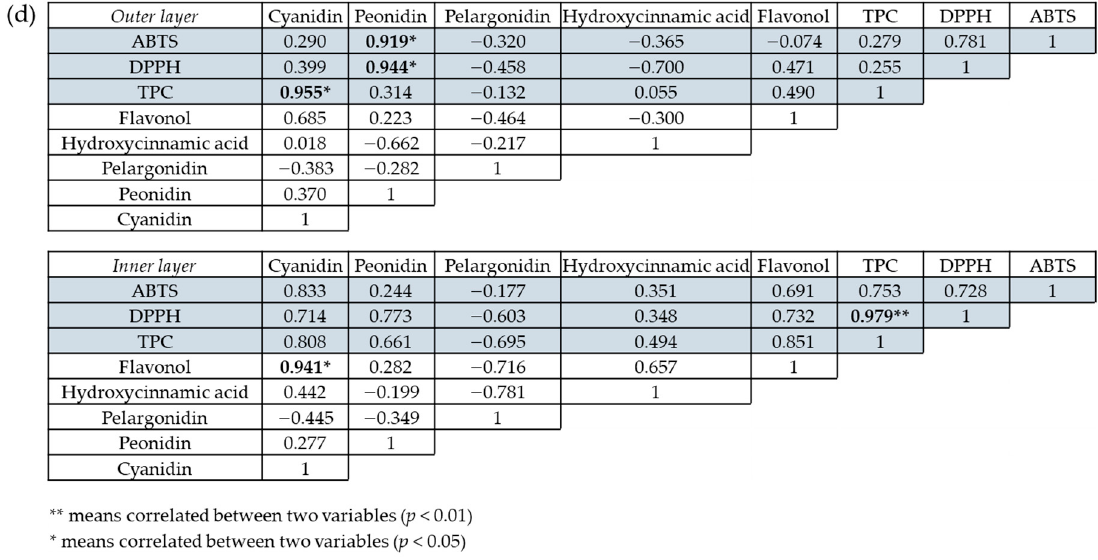
Figure 3. Principal component analysis (PCA) loading plot ( a ), PCA score plot ( b ), and heatmap ( c ) for visualization of varietal comparisons in different tissues (i.e., inner and outer layers) of the five purple sweet potato cultivars (S, Sinjami; D, Danjami; Y, Yeonjami; J, Jami; B, Borami; O, Outer layer; I, Inner layer) based on anthocyanin and non-anthocyanin phenolic compositions. ( d ) Pearson’s correlation among anthocyanins, non-anthocyanin phenolic compounds, total phenolic content, and antioxidant activities (ABTS and DPPH). Bold mean